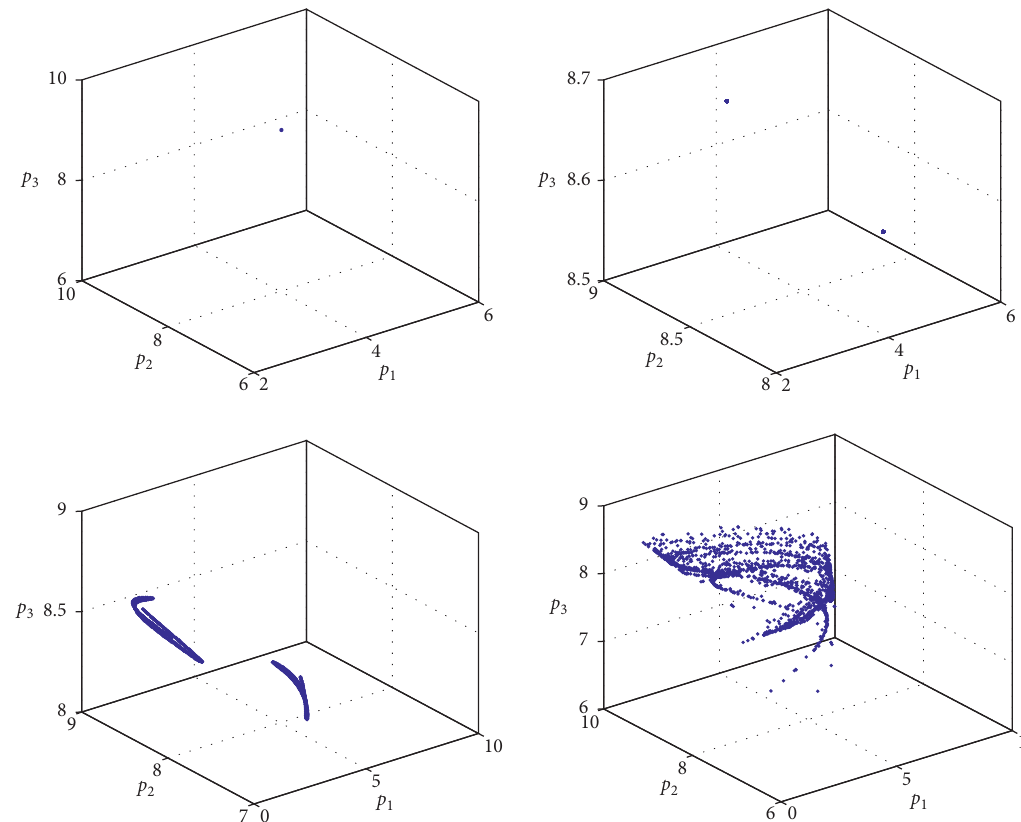
Figure 4: Chaotic attractor of the nonlinear dynamic system (12). (a) α � 0 . 2. (b) α � 0 . 5. (c) α � 0 . 65. (d) α � 0 . 7.